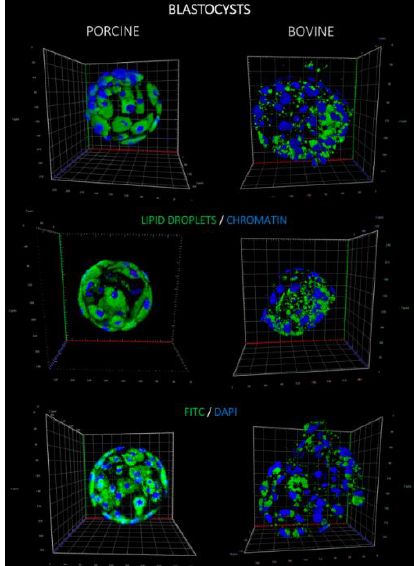
Figure 1. Confocal 3D projections of fluorescently stained porcine (left) and bovine (right) blastocyst stage embryos with BODIPY 493/503 (green) to visualize lipid droplets and DAPI ( 4′,6-diamidino-2-phenylindole; blue) for nucleus staining.